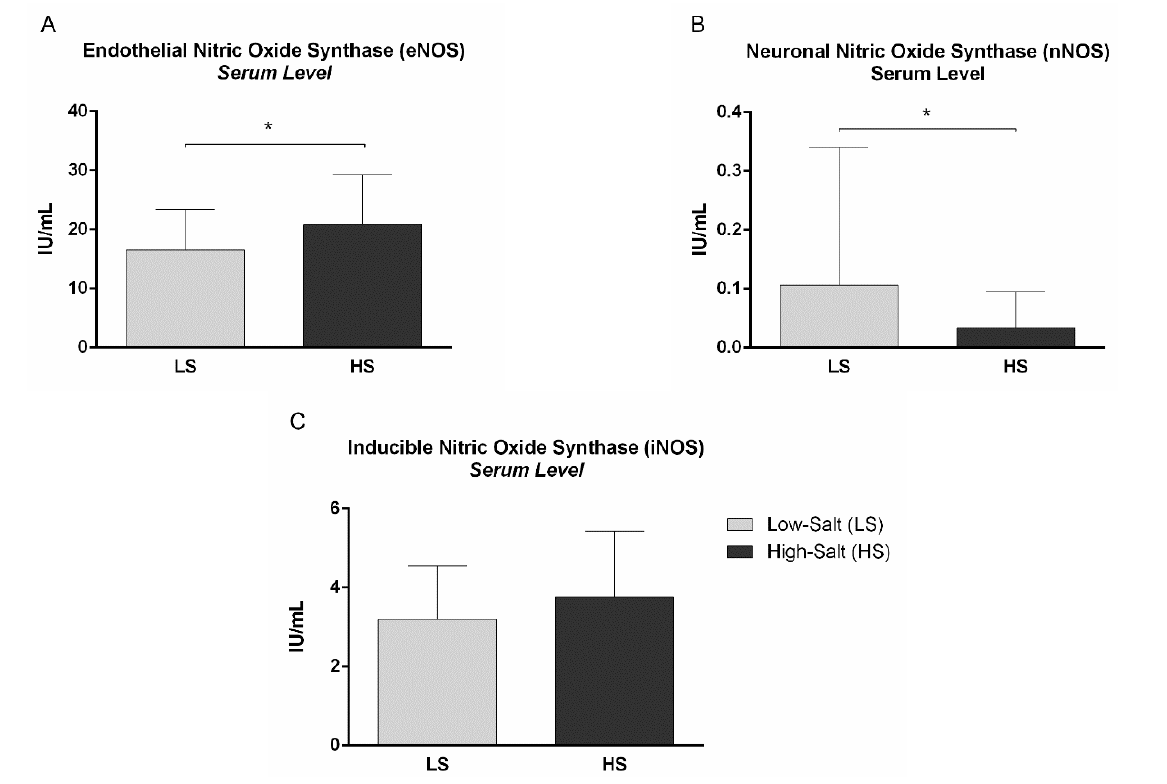
Figure 3. The effect of a 7-day high-salt (HS) diet on endothelial (eNOS) ( A ), neuronal (nNOS) ( B ) and inducible nitric oxide synthase (iNOS) ( C ) serum level in healthy individuals. ( A ) eNOS serum level significantly increased following 7-day HS diet, compared to LS diet condition in healthy individuals. * p = 0.039, LS vs. HS (Paired t -test). ( B ) nNOS level significantly decreased following 7-day HS diet, compared to LS diet condition in healthy individuals. * p = 0.030, LS vs. HS (Paired t -test). ( C ) iNOS serum level remained unchanged following HS diet, compared to LS conditions in healthy individuals. Table 5. Correlations between 24-h sodium excretion/NO serum concentration and endothelial vascular response/NOS isoforms serum